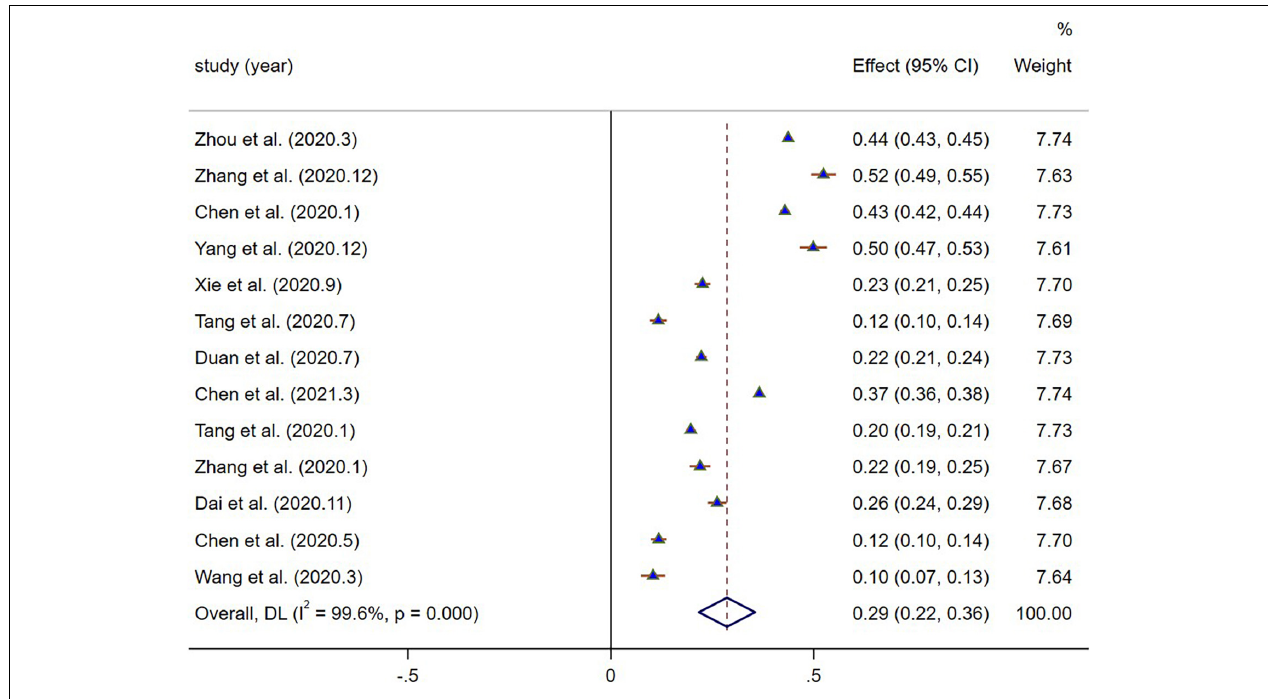
FIGURE 2 | The forest plot of the prevalence of depressive symptoms. TABLE 2 | Subgroup analysis of the prevalence of depressive